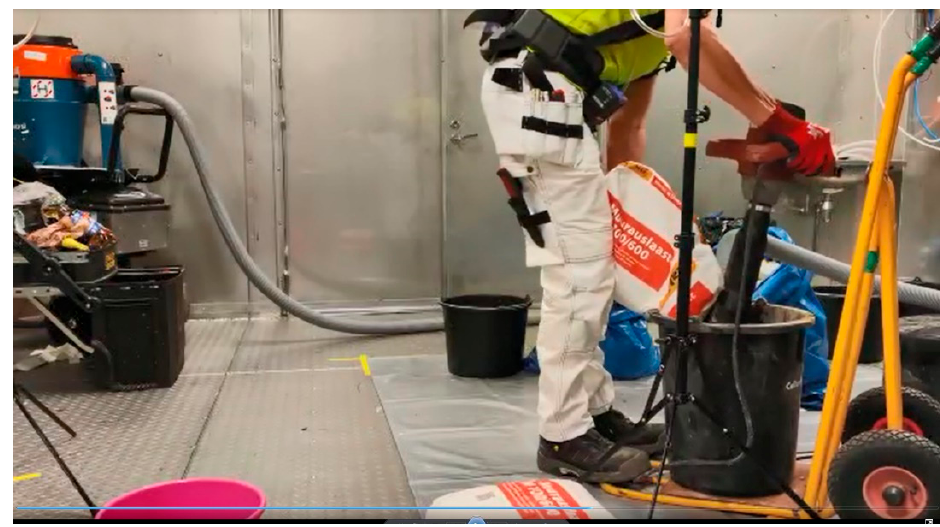
Figure 3. Testing an exhaust vent attached to a blender connected to an H-class vacuum cleaner. Reproduced with permission from Tuomi et al., Finnish Institute of Occupational Health, 2022 [34].